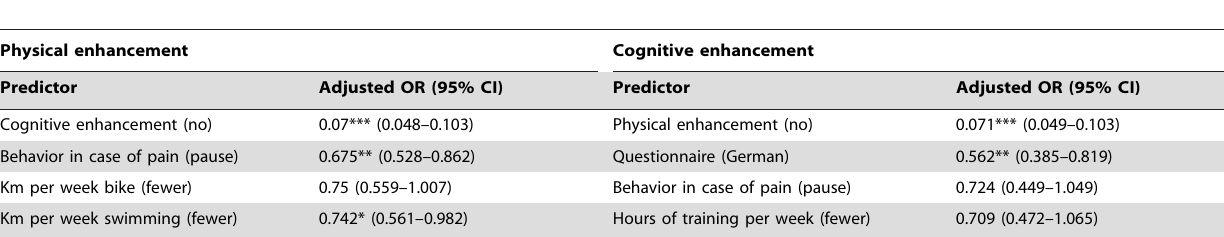
Table 8. Odds ratios for the dependent variables ‘physical enhancement’ and ‘cognitive enhancement’ and each predictor variable (stepwise, feed backward